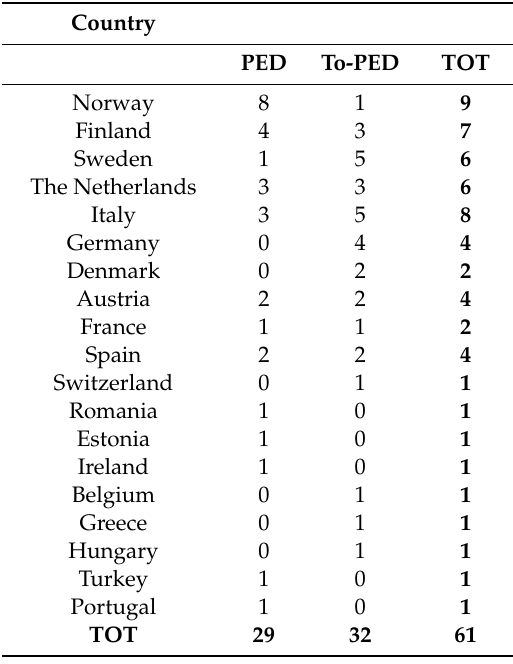
Table 1. Geographic distribution of